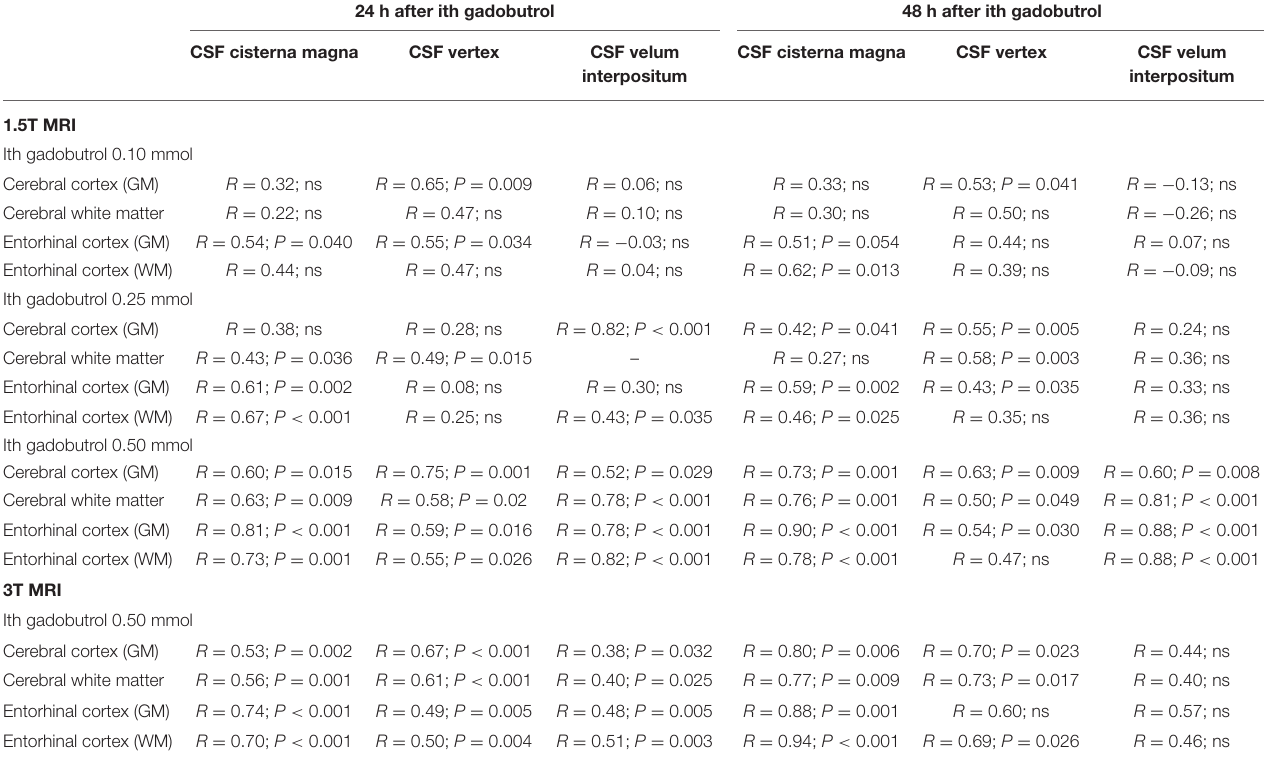
TABLE 5 | Correlations between tracer enrichment within subarachnoid CSF spaces and brain parenchyma. 24 h after ith gadobutrol 48 h after ith